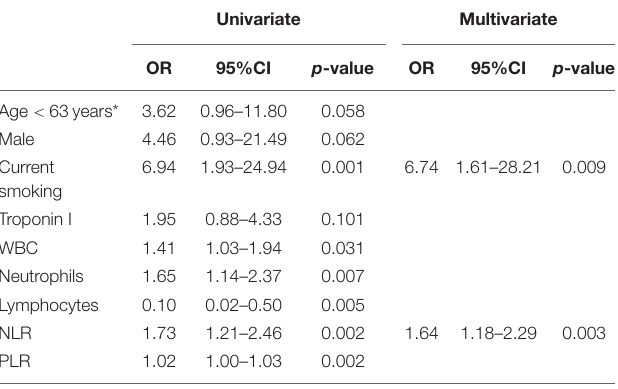
TABLE 3 | Logistic regression analysis for plaque rupture in patients with intermediate coronary artery lesions.